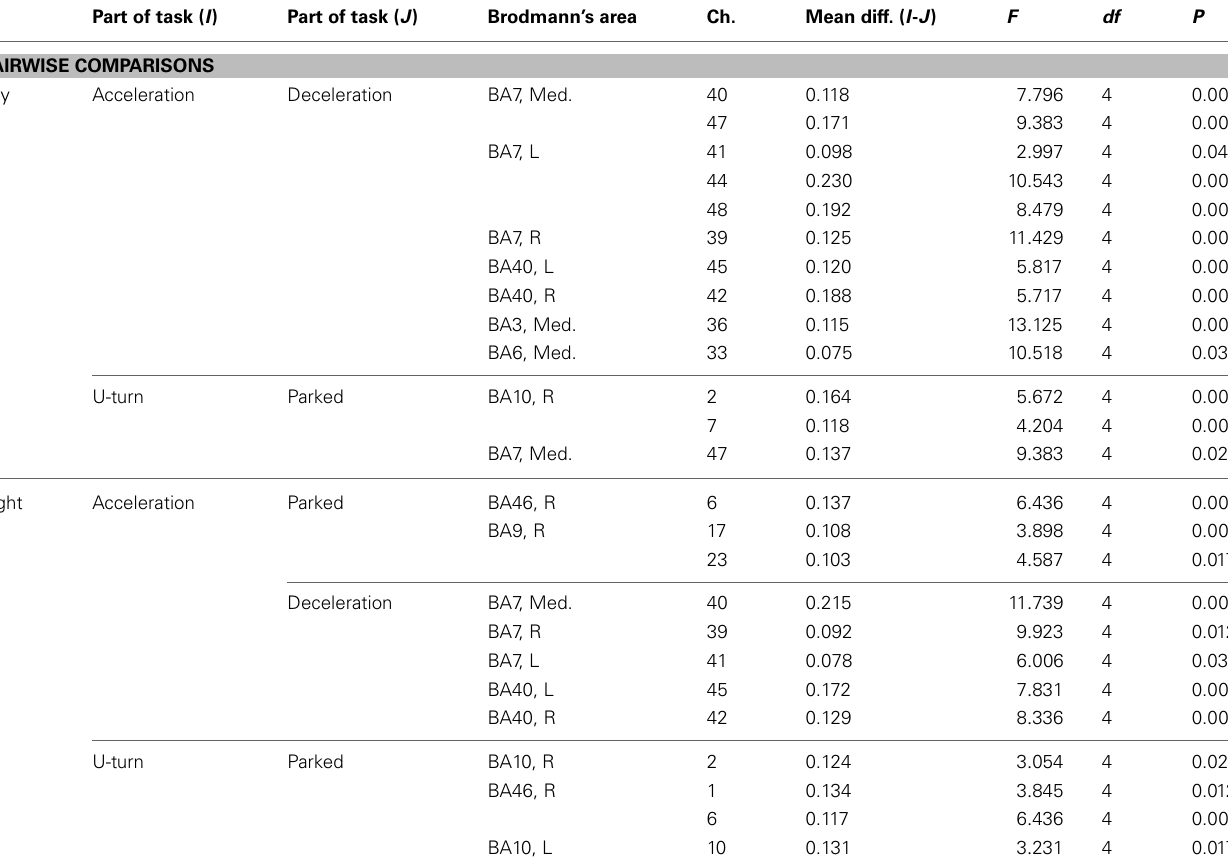
Table A1 | Channels with significant differences in (cid:2) CBV between parts of the task according to a post-hoc test. Part of task ( I